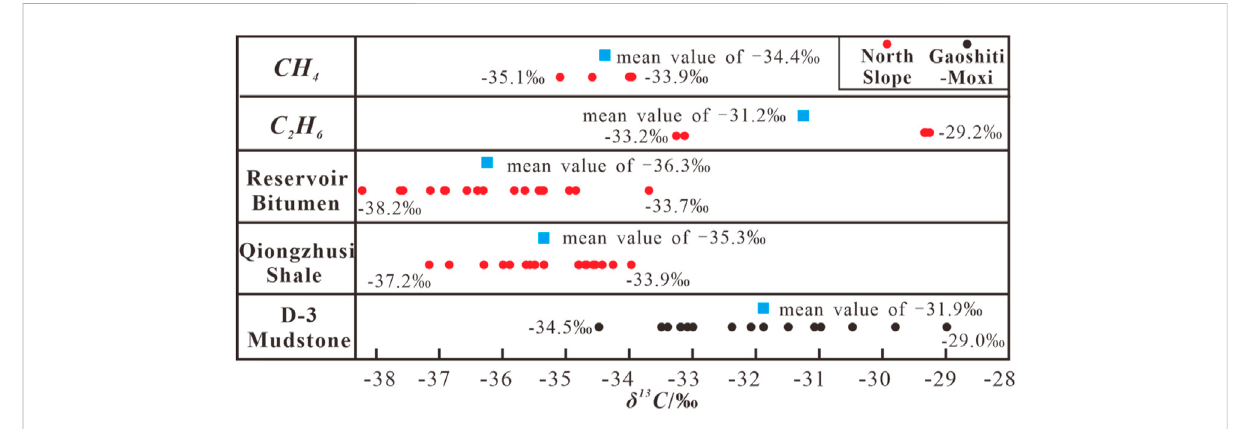
FIGURE 5 The gas/bitumen-source correlation on the North Slope. * Methane, ethane, and solid bitumen are from the Dengying reservoirs of ZJ2 and PT1